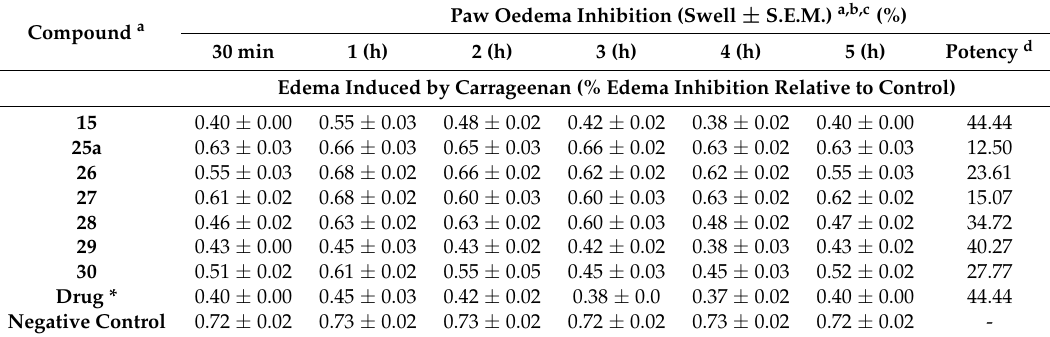
Anti-inflammatory Activity of Tested Compounds ( 15 , 25a , 26 – 30 ) against Acute Carrageenan-Induced Paw Oedema in Rats (Statistical analysis). Compound